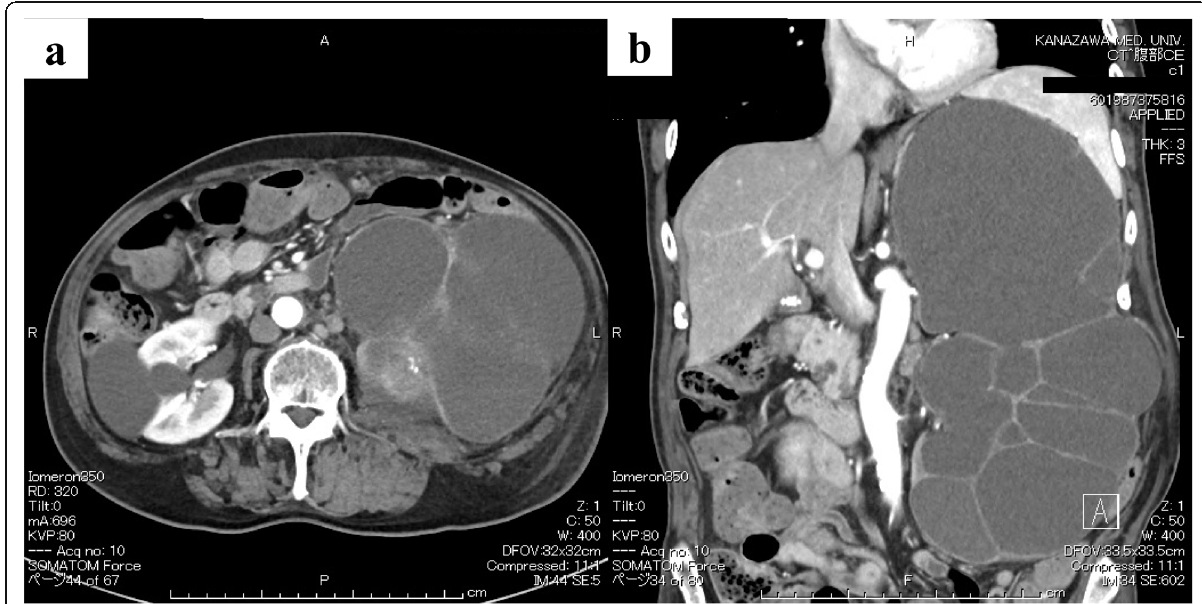
Fig. 1 Computed tomography of the abdomen before nephrostomy. The left kidney was multicystic and markedly